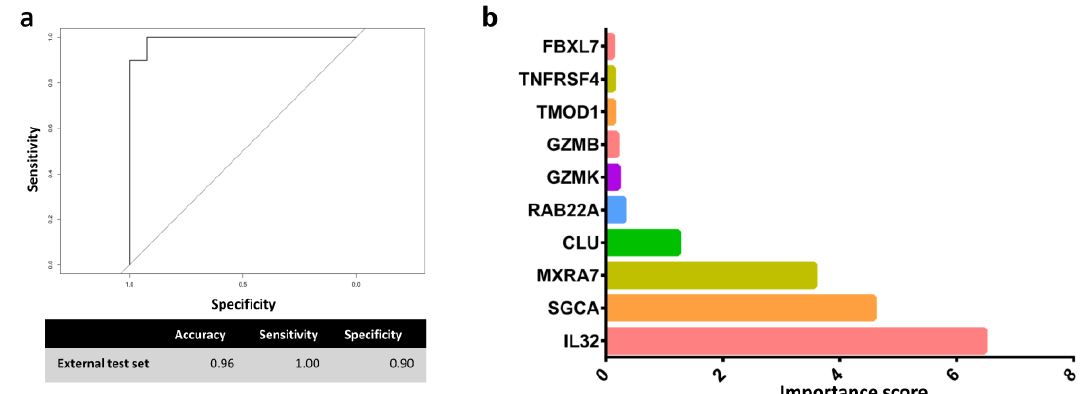
Figure 3. Properties of the random forests model. ( a ) The ROC curve, accuracy, sensitivity, and specificity of the external the test set of the optimal random forest model. ( b ) The top 10 most important features of the optimal random forests model on the training set.